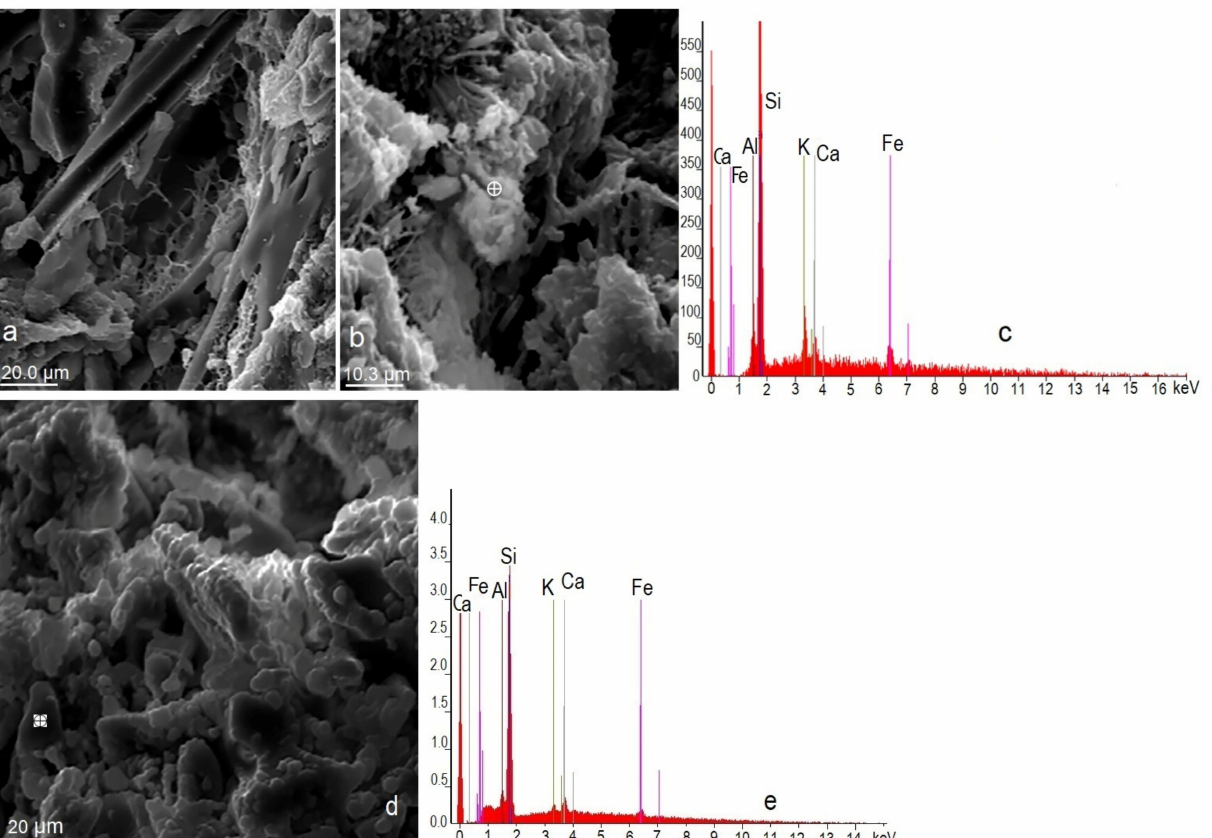
Figure 4. Natural mordenite microphotographs used in this research ( a , b , d ) and EDX diagrams ( c , e ).